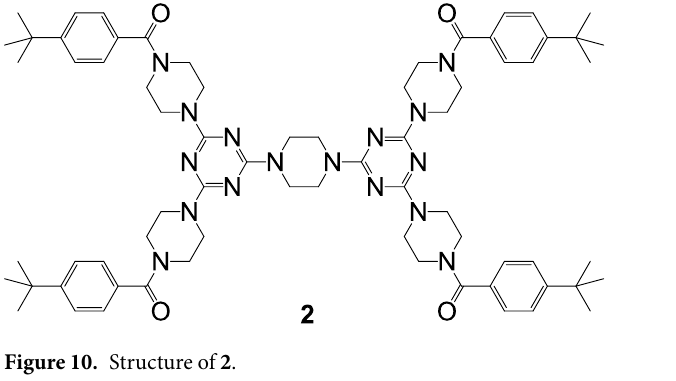
Figure 10. Structure of 2